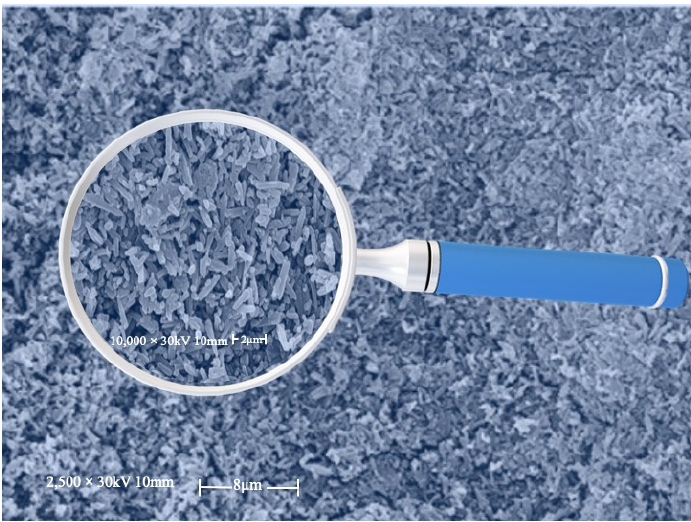
Figure 4. A 10 4 times magnified image of aragonite particles by SEM (modified from [35]).